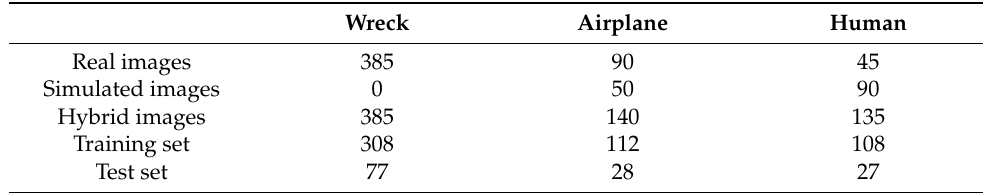
Table 1. Number of various SSS